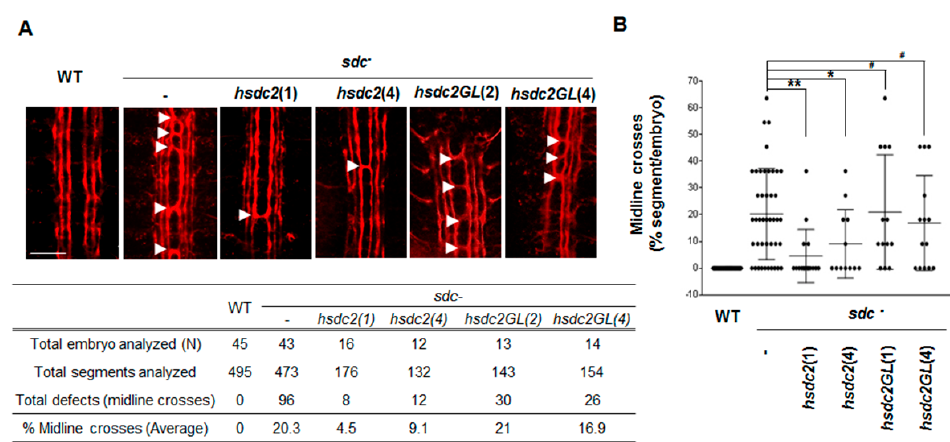
Figure 2. Syndecan transmembrane domain regulates development of the Drosophila midline axon. ( A ) Representative images from FasII-stained embryos of wild-type (WT, left column) and transgenic flies expressing wild-type or mutant hsdc2 in the sdc mutant background ( sdc- ). The inner axon fascicles crossing over the ventral midline are indicated with white arrows. Scale bar = 20 µ m. ( B ) Percentage of segments showing midline cross over of axon fascicles in wild-type and sdc mutant embryos expressing wild ‐ type or mutant hsdc2. Each dot corresponds to an analyzed embryo, and at least 12 embryos were analyzed per genotype. Bars represent average ± standard deviation; * p < 0.05 , ** p < 0.001 , # p > 0.5.